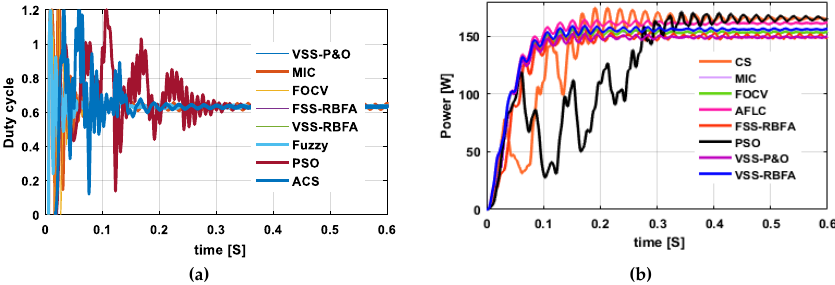
Figure 16. ( a ) Duty cycle and ( b ) output power of a stackable switching boost converter (SSBC) by applying different MPPT techniques at 800W/m 2 .